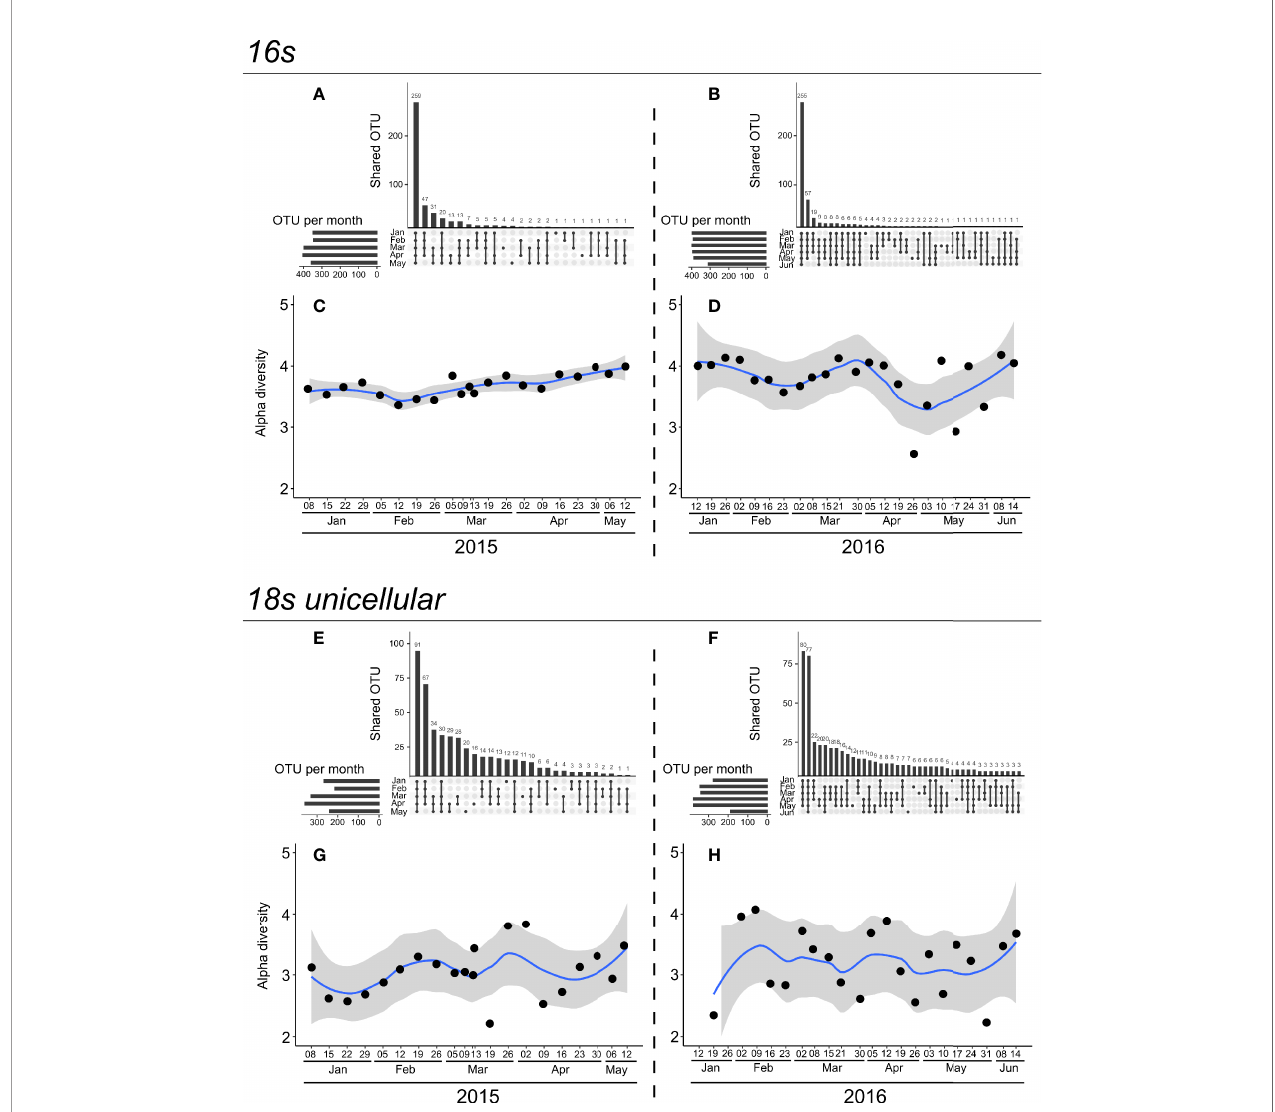
FIGURE 1 | UpSet diagrams (A, B, E, F) of number of OTUs shared between periods and alpha diversity of Shannon index (C, D, G, H) for 16s (upper panel) and 18s rRNA gene unicellular OTUs (lower panel) in 2015 (left) and 2016 (right) years. UpSet diagrams represent the number of common and unique OTUs between months. For example, for 16s in 2015 (A) , 13 OTUs are common and represented only in April and May (5 th bar). The total numbers of OTUs identi fi ed per month are represented as horizontal bars on the left side of each UpSet diagram. Temporal alpha diversity was smoothed using a LOESS function, represented by a blue line. Grey background is the 95% con fi dence interval of LOESS smoothing